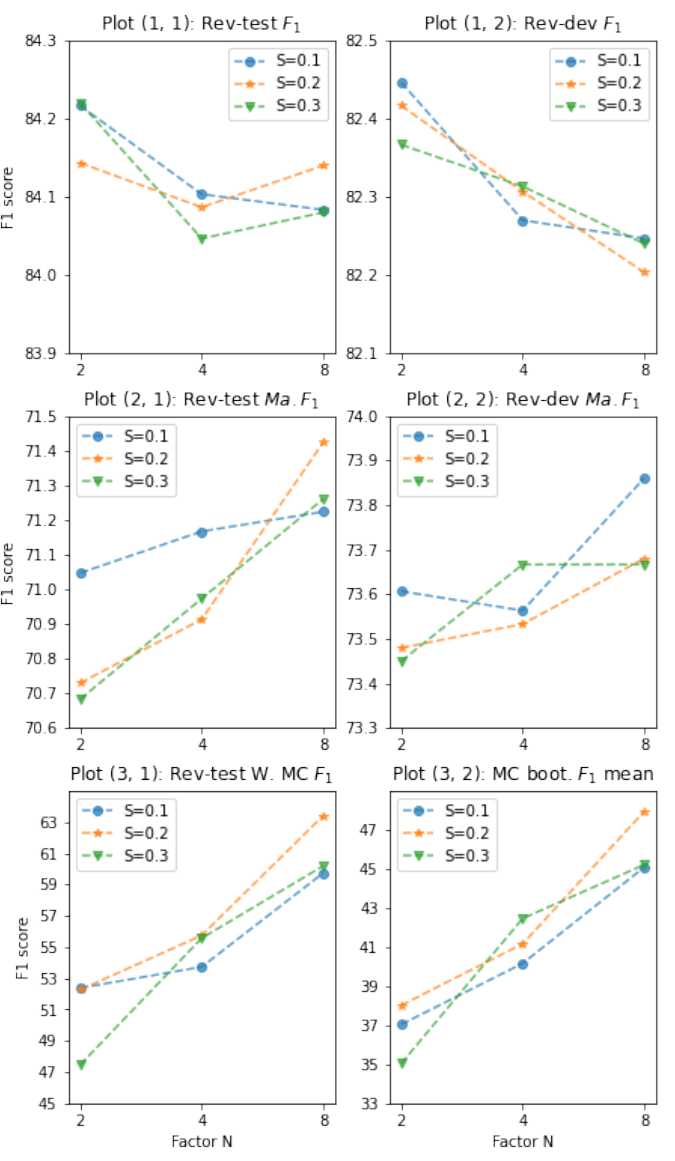
Figure 4. Augmentation settings and F1 scores on Rev-TACRED test and dev datasets. Y -axis is F1; X -axis is scale factor N ; legend S is the proportion of the token replacements; and MC boot. F1 in plot (3, 2) denotes the bootstrap mean of MC F1